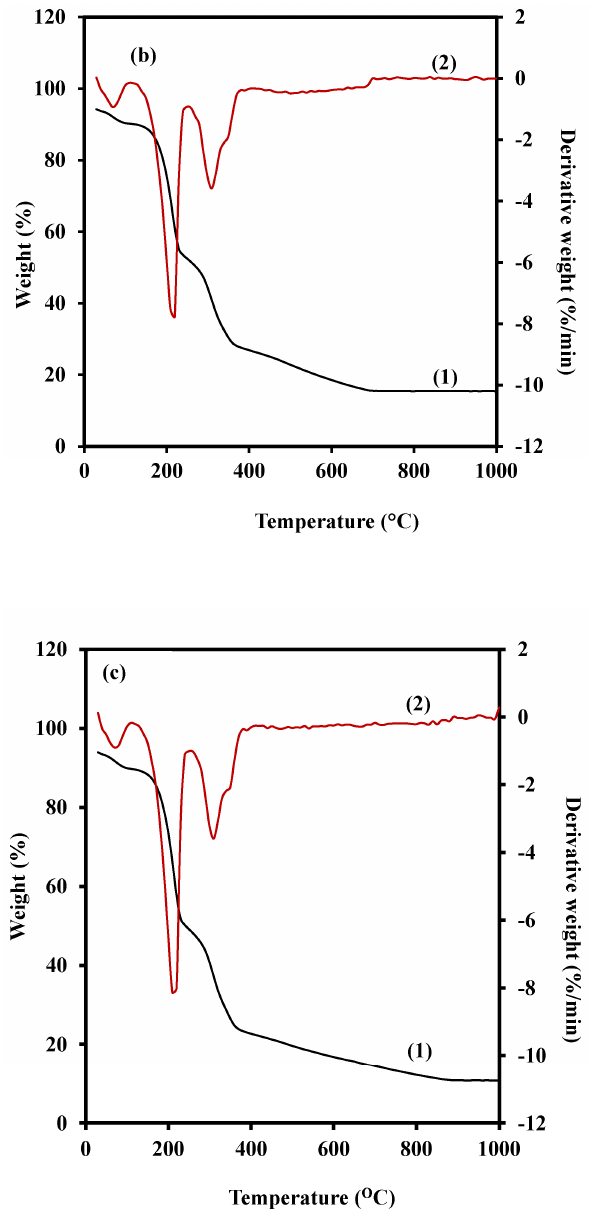
Figure 5. (1) The thermogravimetric analysis (TGA) curves and (2) derivative thermogravimetric (DTG) curves for G 35 ( a ), G 35 ( b ), and G 35 ( c ) films prepared using 0.28 t, 0.42 t, and 0.84 t pressure levels, respectively. Table 2. Stage-wise mass loss (%), Residual mass (%), and peak temperatures ( ◦ C) of G 35 A, G 35 B and G 35 C